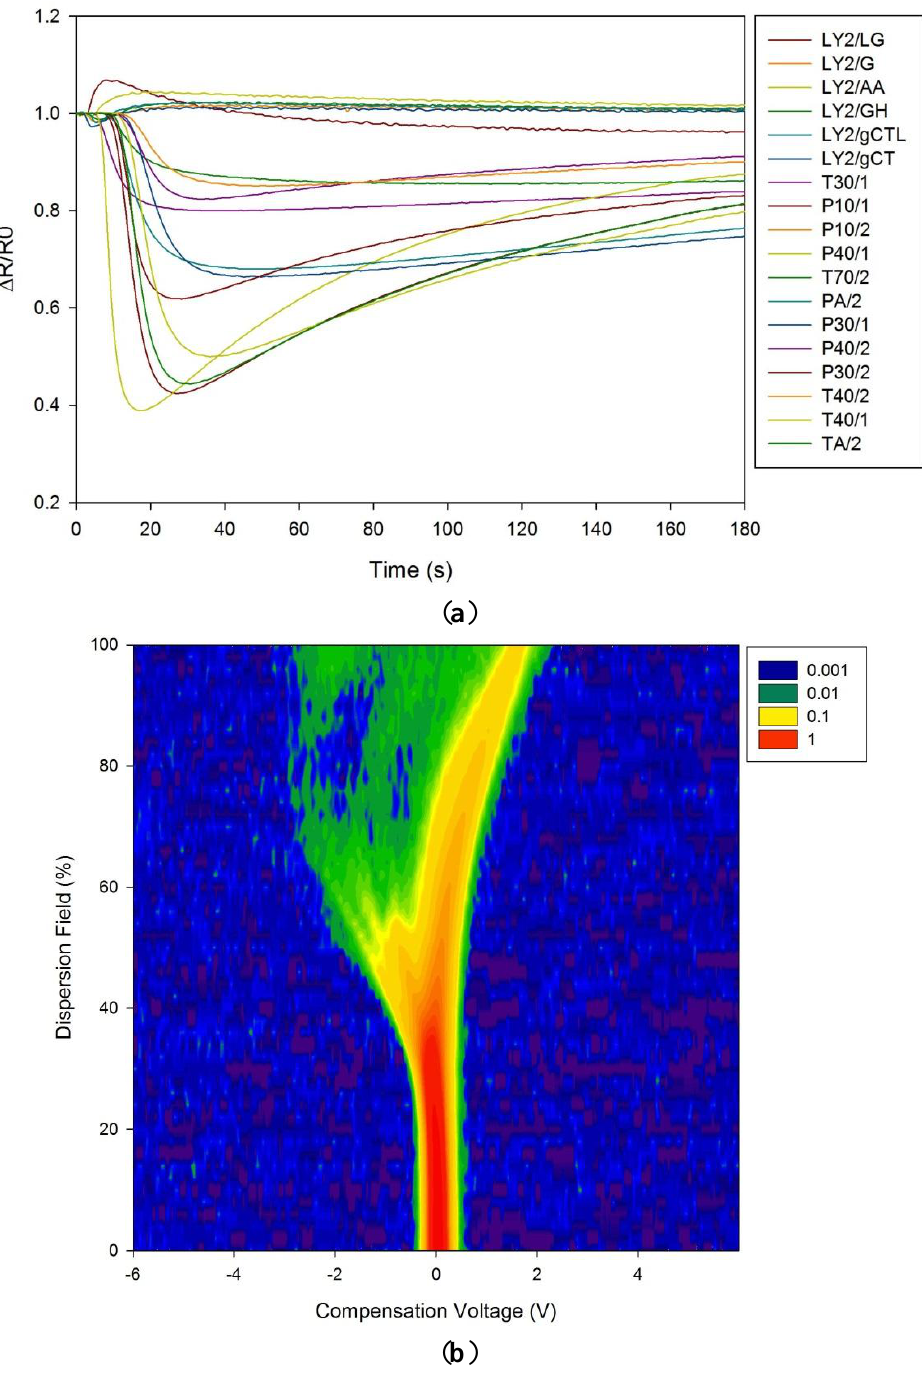
Figure 1. ( a ) Raw electronic nose results showing the sensor responses to a BAD patient urine sample. ( b ) Raw data from the FAIMS instrument to a BAD patient urine sample. Intensity is in arbitrary units of ion